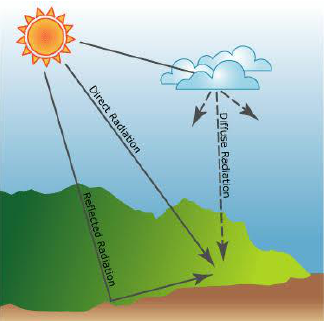
Figure 2. Solar Radiation Components ©ArcGIS